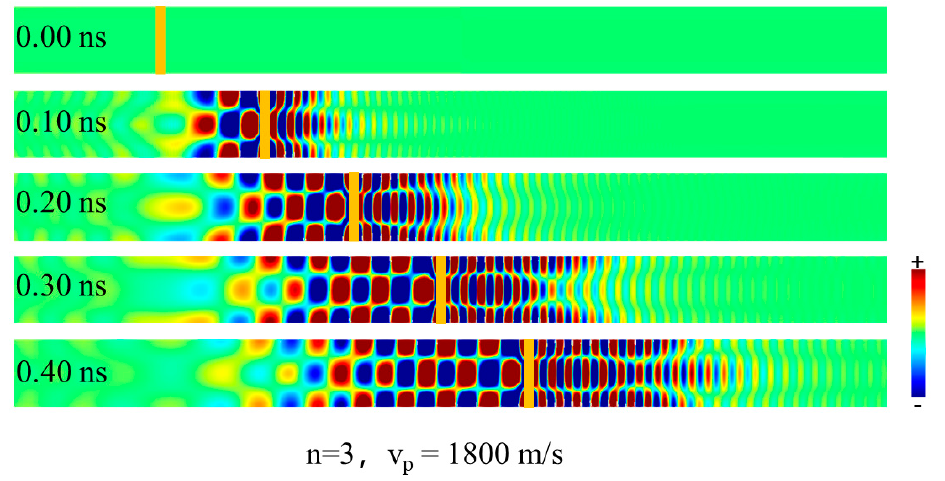
Figure 5. Time-serial snapshots of SW pattern excited by a field pulse moving with a speed of 1800 m/s. The yellow bar indicates the location of the moving field pulse at different times.